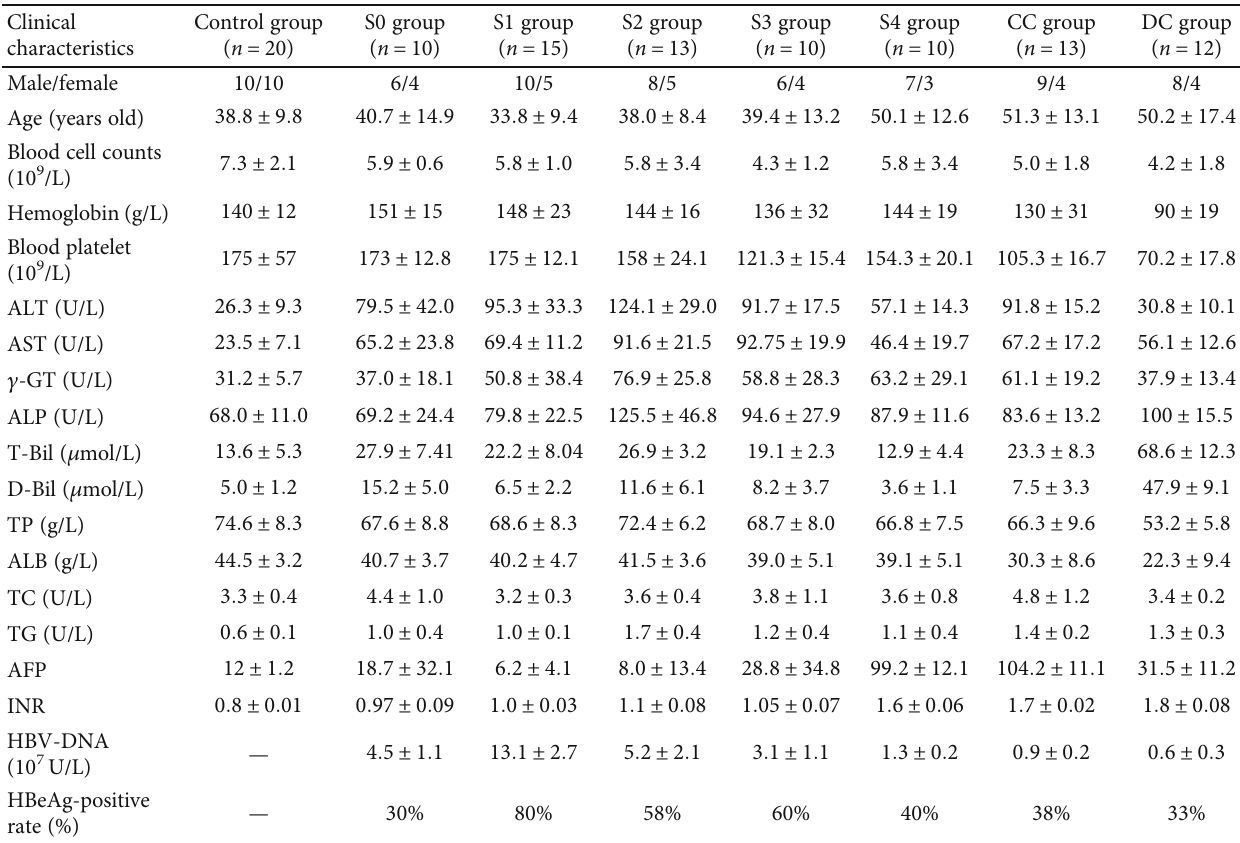
Table 1: Clinical characteristics of the 83 participators ( (cid:1) x ± s